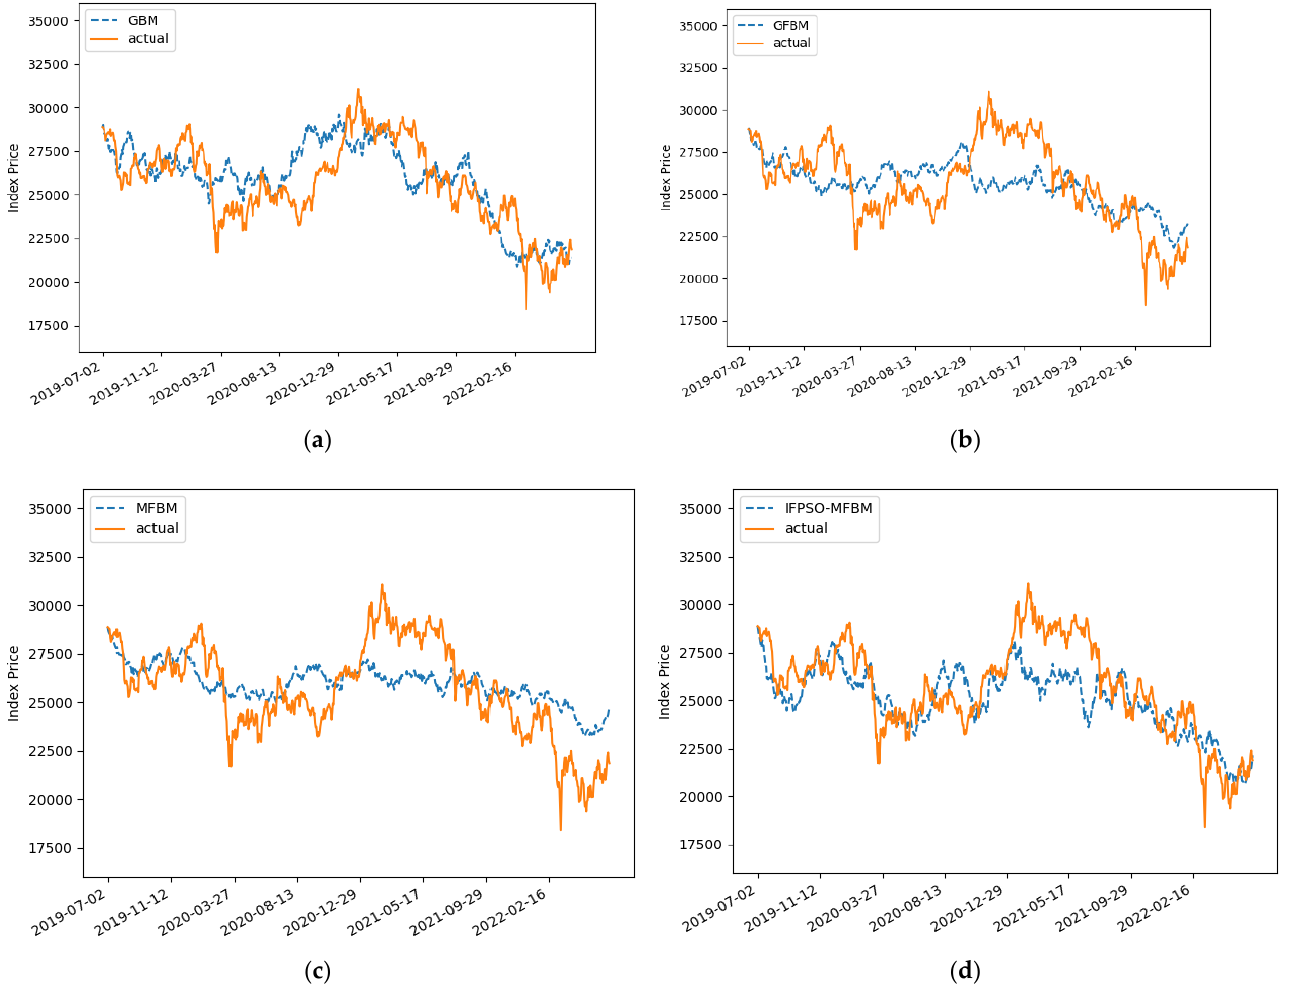
Figure 6. Comparison of the true and predicted values of Hang Seng under the four models. ( a ) GBM, ( b ) GFBM, ( c ) MFBM, ( d ) Table 8. Comparative error analysis of Hang Seng index under four models.